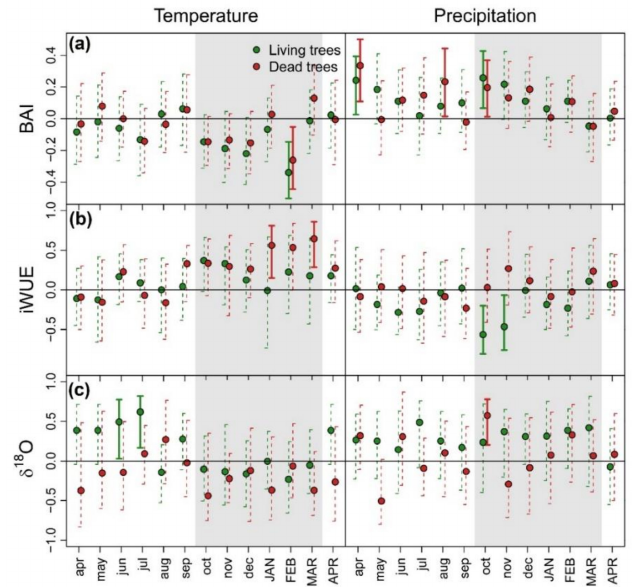
Figure 4. Bootstrapped correlations between monthly mean temperature (left) and precipitation (right) and basal area increment (BAI) ( a ), intrinsic water-use efficiency (iWUE) ( b ) and oxygen isotope composition ( δ 18 O) ( c ) of tree rings of living (green symbols) and dead (red symbols) Nothofagus dombeyi trees. BAI, iWUE and δ 18 O were detrended using ensemble empirical mode decomposition (EEMD) technique prior analysis. Error bars are 95%-confidence intervals and significant and non- significant effects are represented by solid and dash bars, respectively. Grey shaded areas indicate growing season of the year of ring